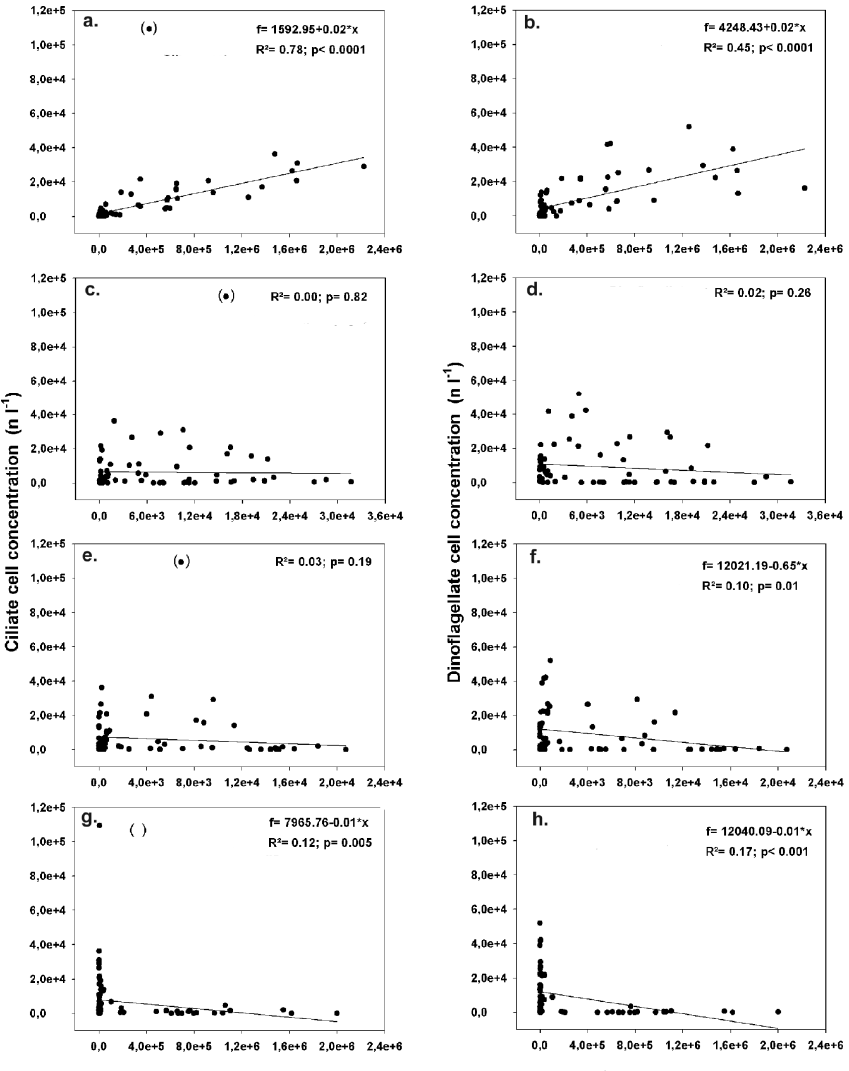
Fig. 9. Patterns of co-occurrence ciliates (graphs on the left) and dinoflagellates (on the right), with their potential food sources: total flagel- lates (a–b) , chlorophytes (c–d) , cyanobacteria (e–g) , diatoms (g–h) . The significance of the relationships was analysed by linear regression analysis. Regression equations for relationships significant at the 5% level are given in the relevant plots. All Lena Delta and coastal sites were included in the analysis, n =